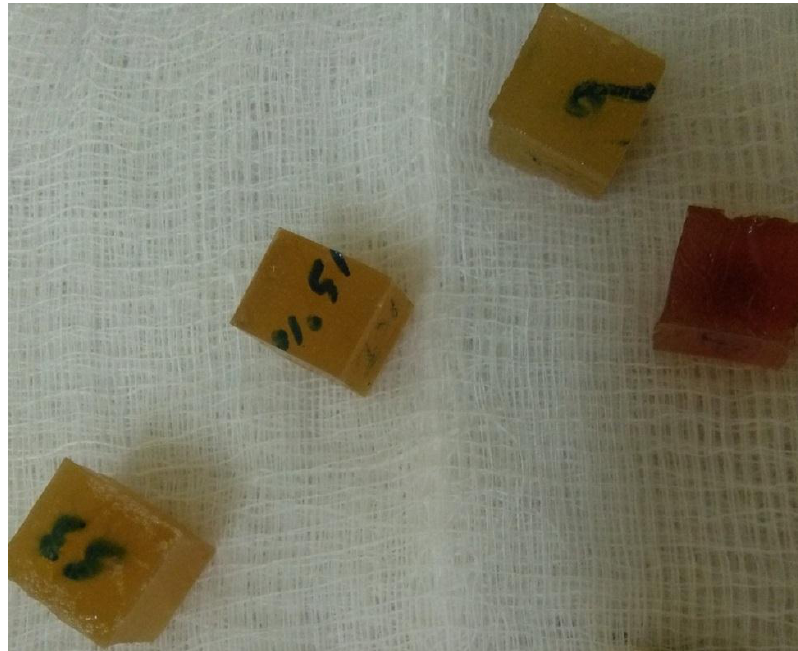
Fig. 2: Samples of diffusivity for blend+sand53